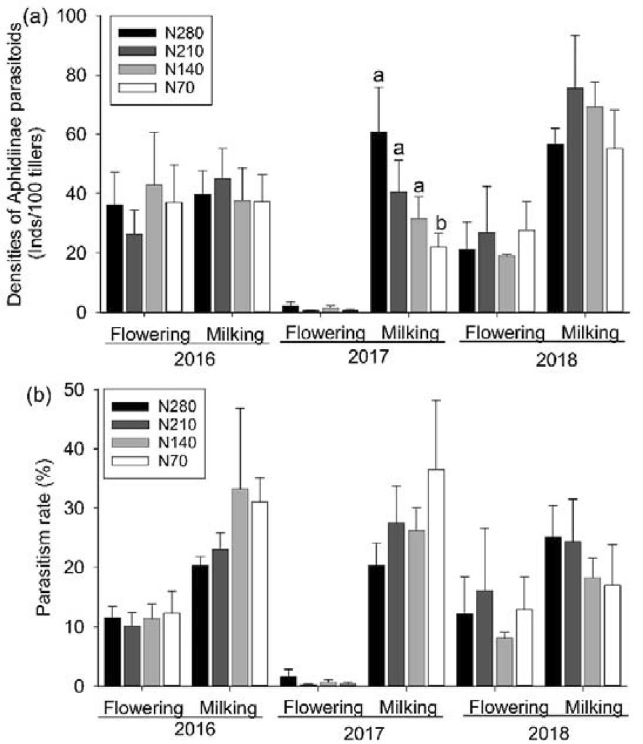
Figure 2. Densities of Aphidiinae parasitoids ( a ) and parasitism rate ( b ) (means + SE) in nitrogen fertilizer plots at the wheat flowering and milking phases during